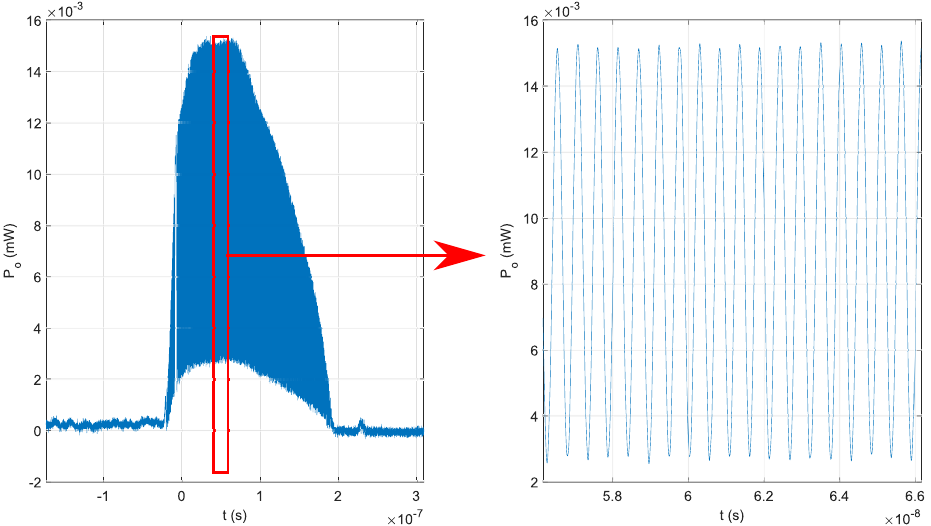
Figure 7. Generated optical signal with EDFA in the optical signal evaluation’s second experiment.